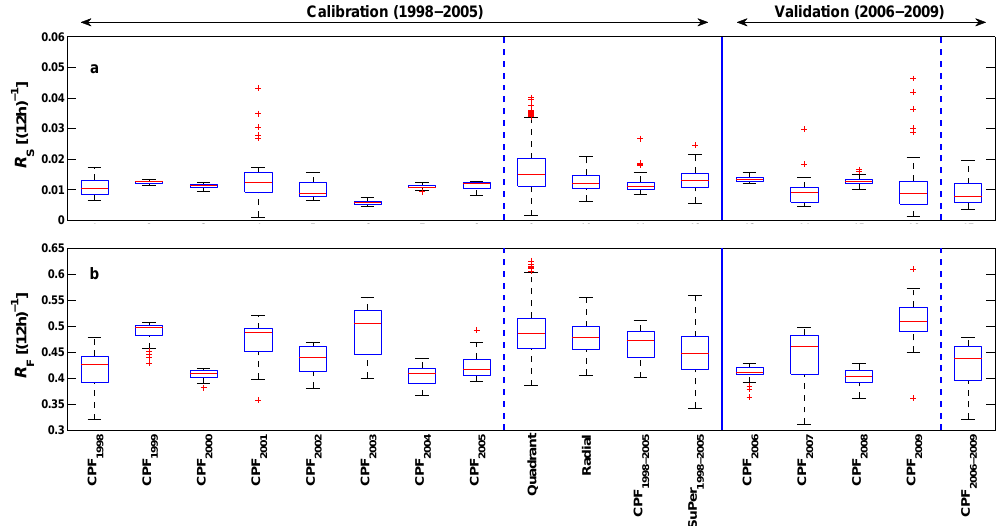
Fig. 9. Parameter distributions of fast reservoir coefficient ( R F ) and slow reservoir coefficient ( R S ) for the calibration Pareto front of every individual year and the entire calibration and validation periods. Whiskers represent the 1.5 times the interquartile range (IQR) and the red crosses show